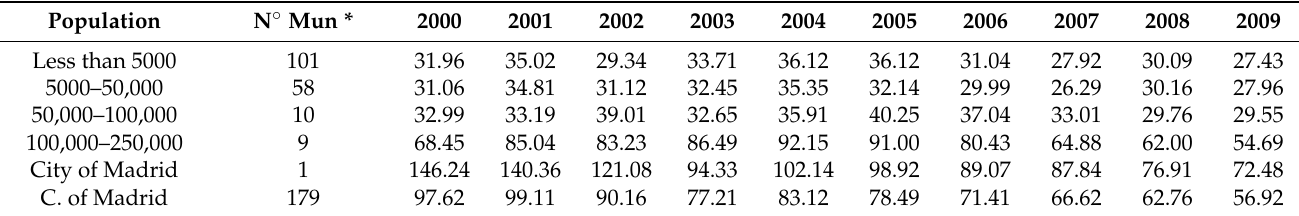
Table 1. Evolution of the mean level of NOx ( µ g/m 3 ) in the municipalities of the Community of Madrid (grouped by population size,